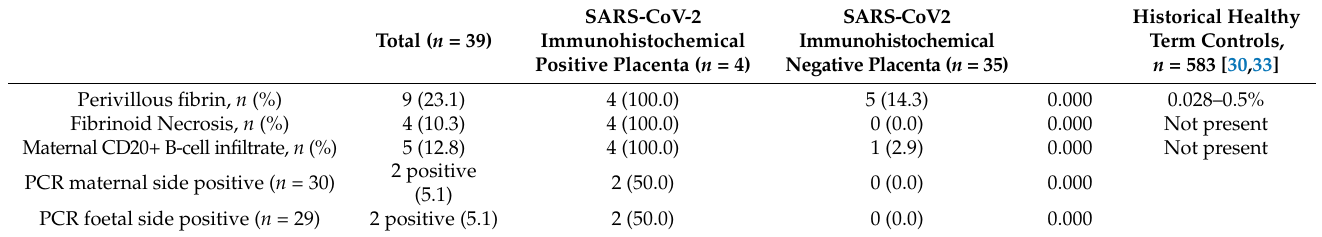
Table 5. Placental characteristics for the total study population and subgroups positive and negative SARS-CoV-2 immuno- histochemical